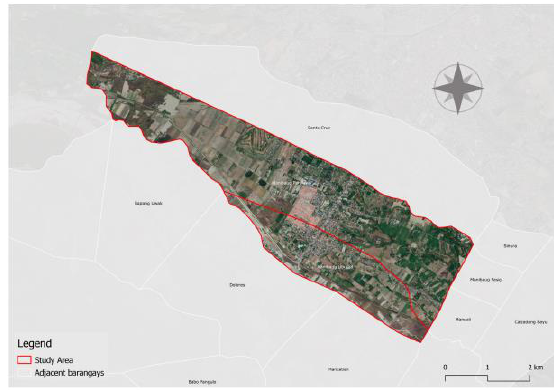
Figure 1. The study area in Porac,